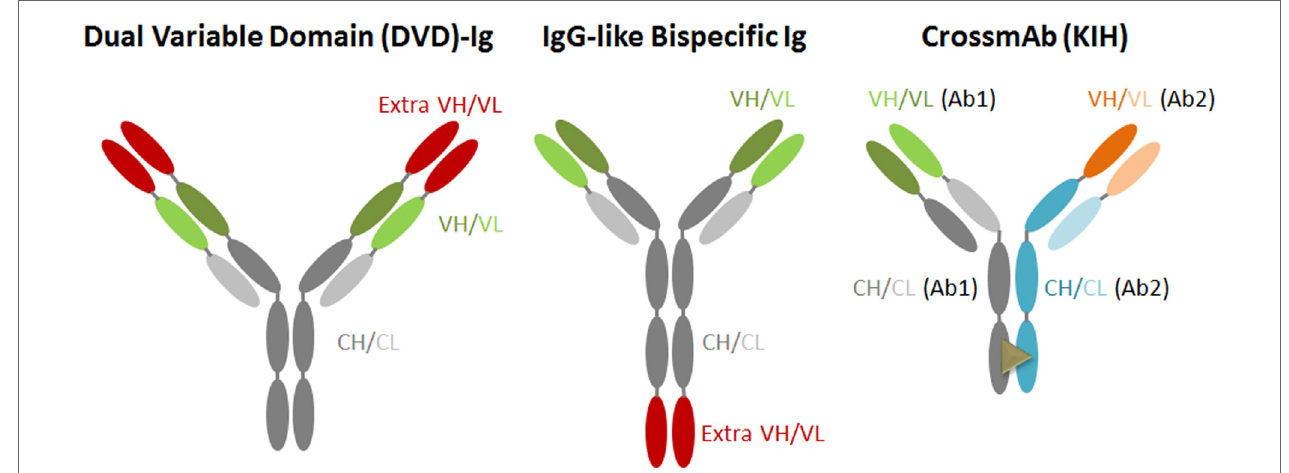
FiGURe 2 | Schematics of engineered antibodies for anti-Hiv-1 investigations